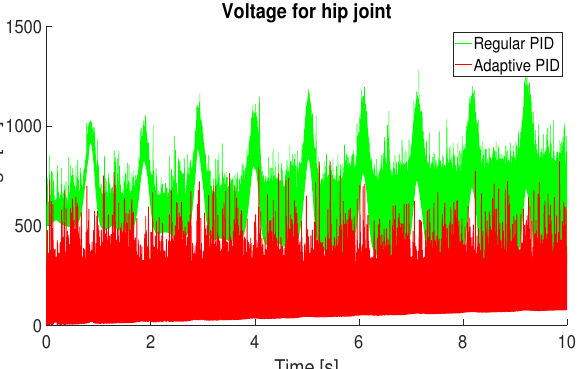
Figure 11. Norm of the voltage evolutions with the application of the regular PID and the adaptive controller proposed in this study.